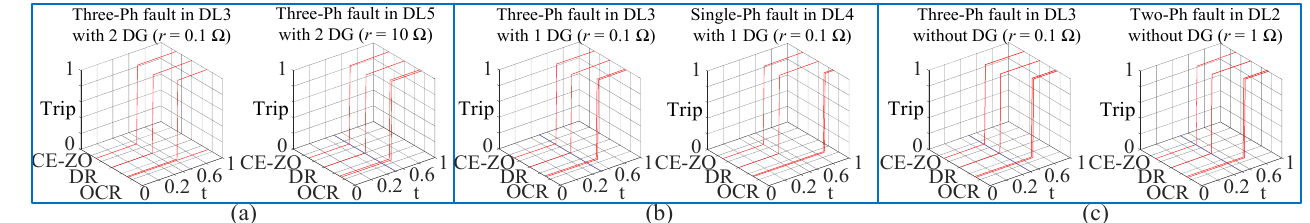
Figure 6. Trip signal of OCR, DR, and CE-ZO behavior during symmetrical and unsymmetrical faults